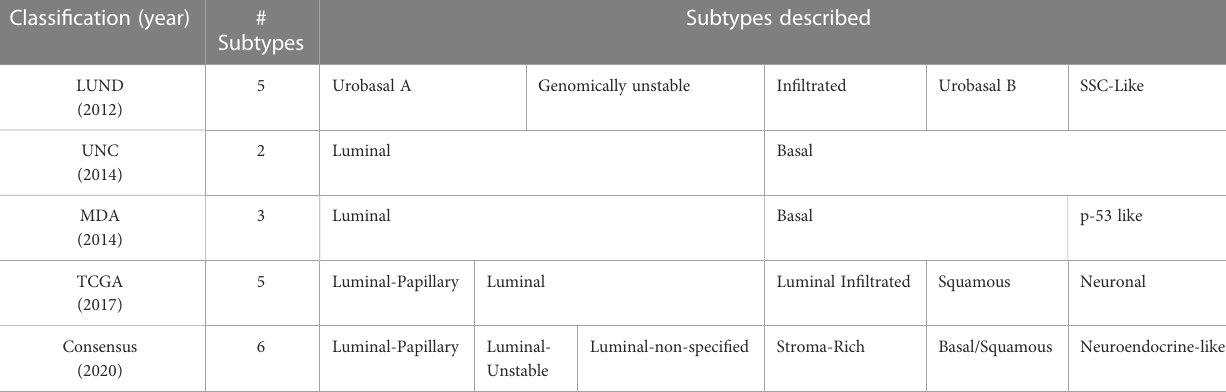
TABLE 2 Classi fi cation systems for bladder tumor